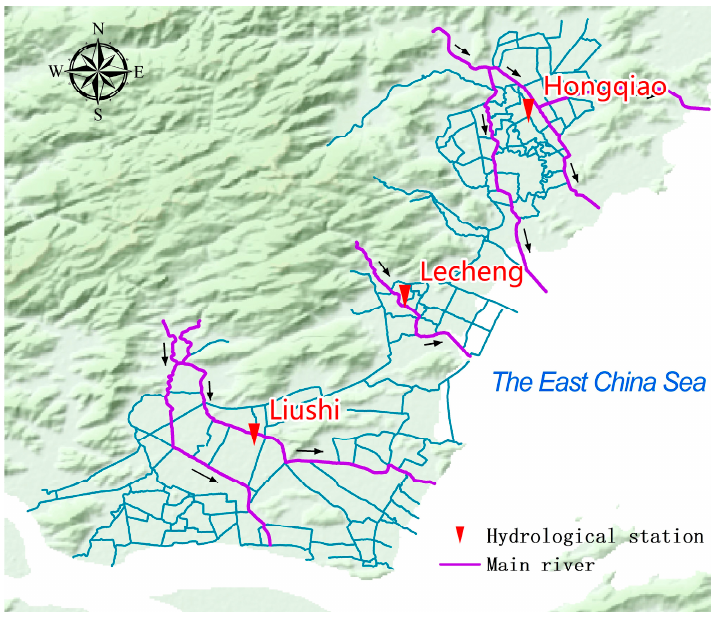
Figure 6. Schematic diagram of the Le Liu Hong plain river network.